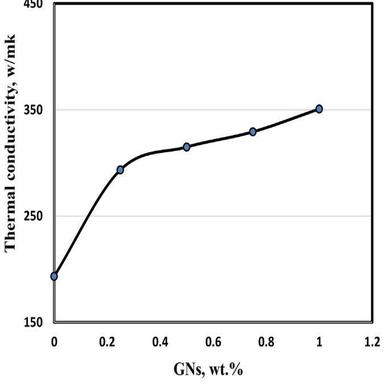
Thermal conductivity of Cu/WC-TiC-Co/GNs nano composites.